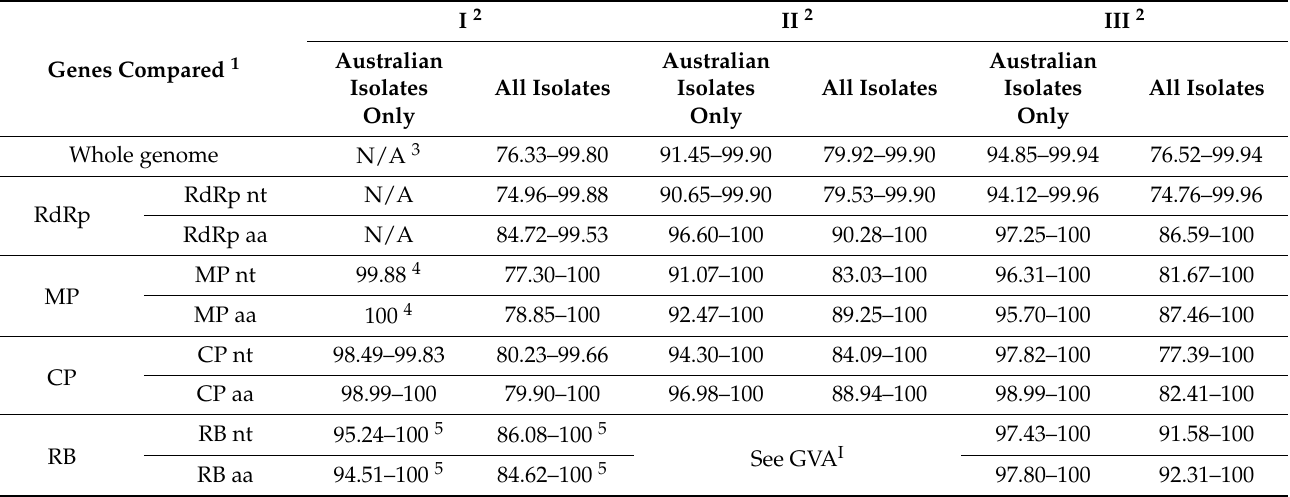
Table 3. Sequence similarity within and between phylogroups of grapevine virus A (GVA) of the Australian isolates obtained by metagenomic high-throughput sequencing and international isolates from the GenBank